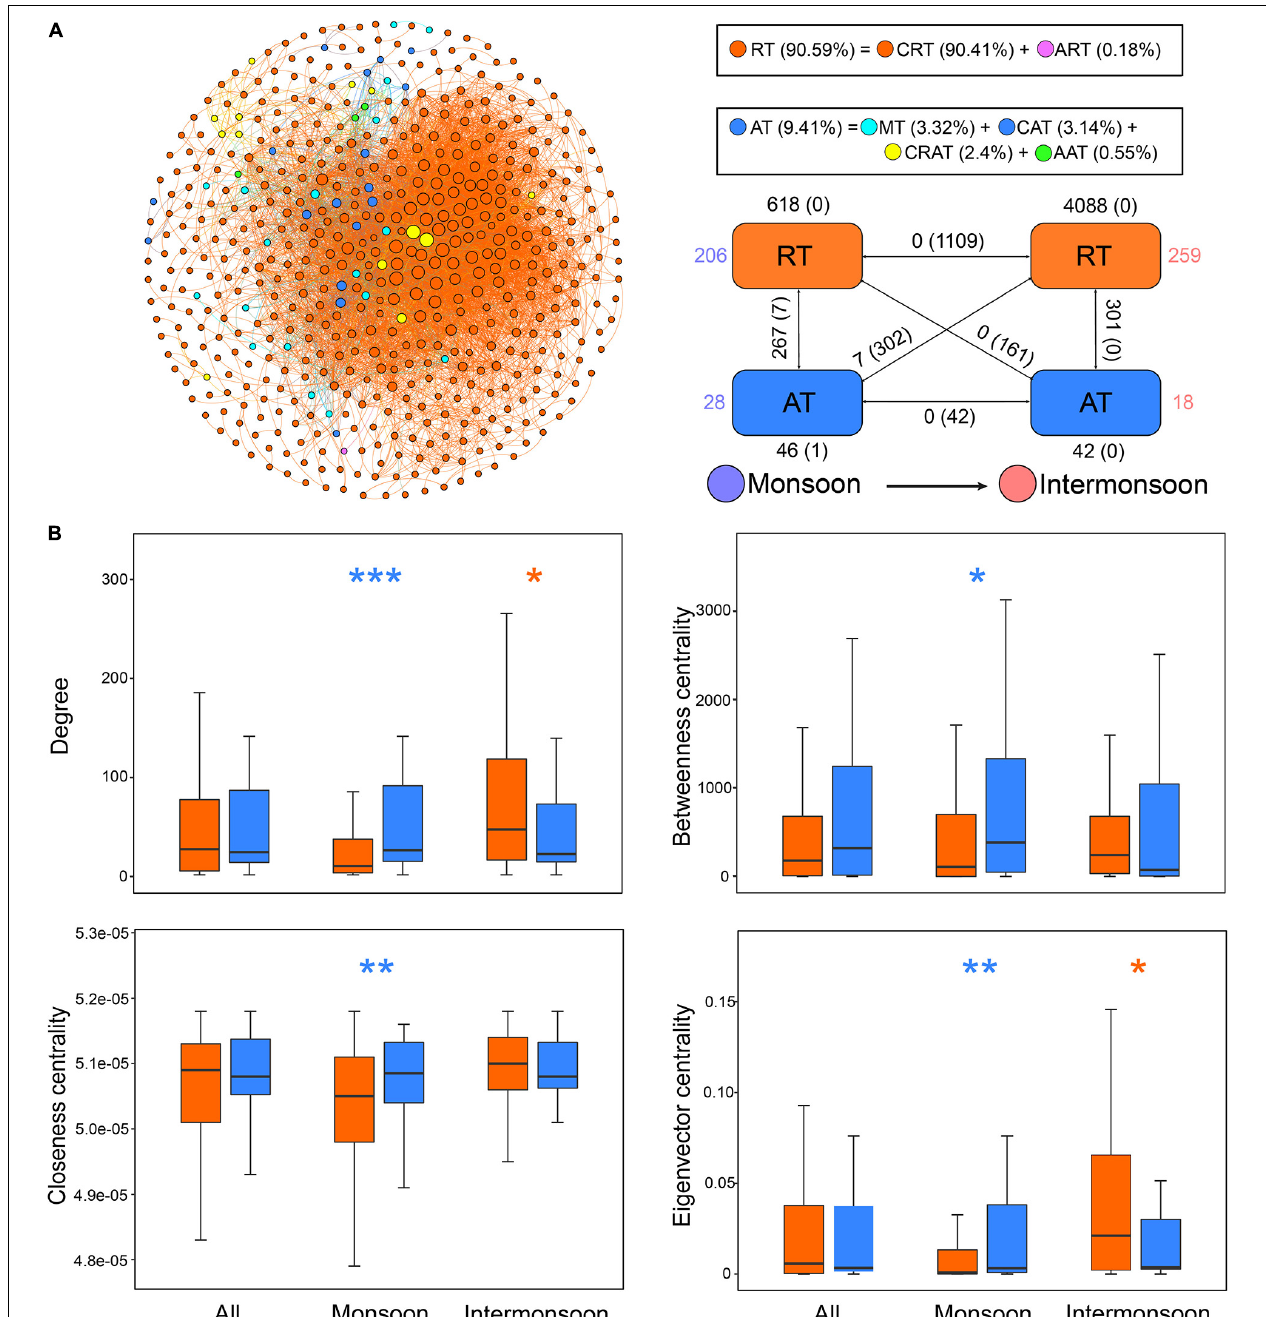
FIGURE 4 | Different roles of rare taxa and abundant taxa in the co-occurrence network. (A) The network was conducted by strong (Spearman’s | r | > 0.8) and significant ( p -value < 0.01) correlations between OTUs in the metacommunity. Each node represents an OTU, and each edge represents a correlation. The size of nodes is proportional to the degree of corresponding OTUs (the number of connections). The networks were colored based on the relative abundance of OTUs, showing seasonal variation through the intra-associations within each taxon and inter-associations between two taxa. The rectangle located at the bottom right of the network figure is a summary of the intra-associations and inter-associations. Colored numbers indicate the number of nodes belonging to the corresponding category (i.e., there were 206 RT nodes in the “monsoon” category). Numbers outside and inside parentheses, respectively, indicate the numbers of positive edges and negative edges. Black numbers near the apex of the rectangle in turn indicate the number of intra-associations. Numbers near rectangle edge in turn indicate the number of cross-group interactions. (B) Comparison of node-level topological features among metacommunity and subcommunities for rare taxa and abundant taxa. Blue asterisks indicate the values significantly higher in abundant taxa (* p < 0.05; ** p < 0.01; *** p < 0.001; Wilcoxon rank-sum test or Brown Mood median test); orange asterisks indicate the properties significantly higher in rare taxa. RT, rare taxa; CRT, conditionally rare taxa; ART, always rare taxa. AT, abundant taxa; MT, moderate taxa; CAT, conditionally abundant taxa; CRAT, conditionally rare and abundant taxa; AAT, always abundant taxa.